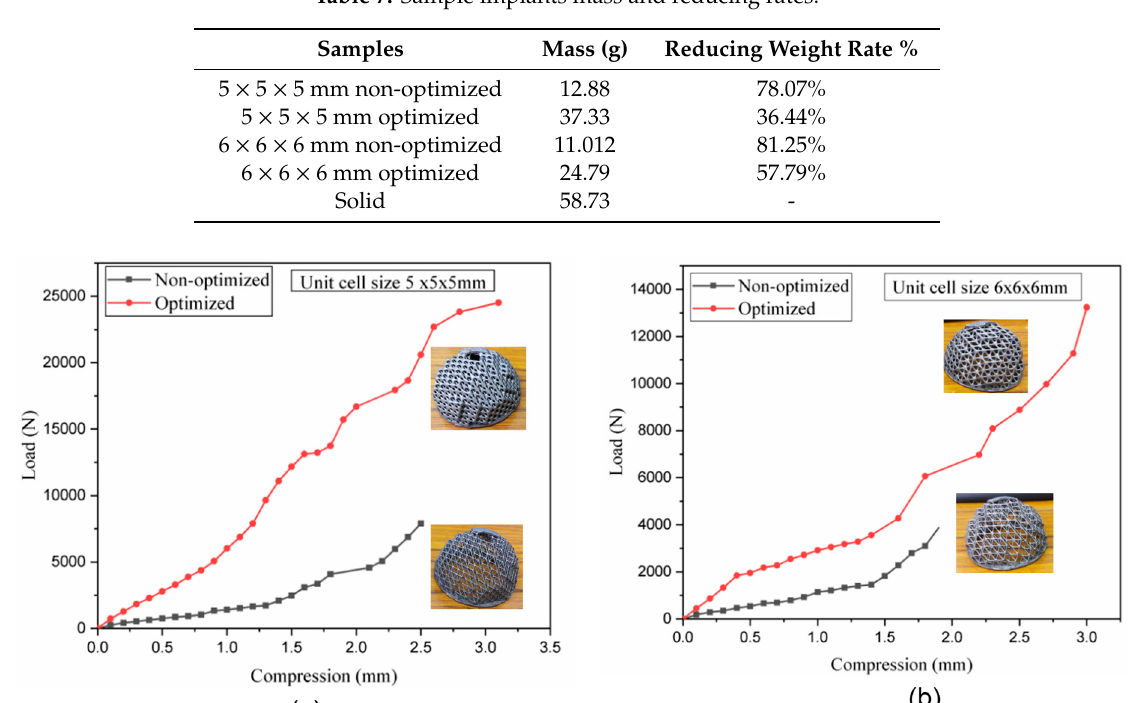
Table 7. Sample implants mass and reducing rates.